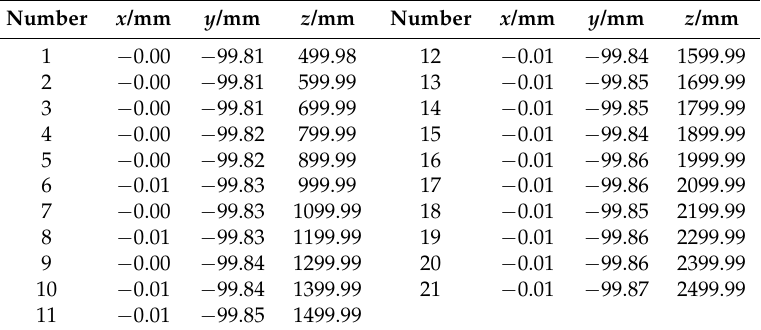
Figure 5. The images of P in the left and right simulated cameras. ( a ) left image; ( b ) right image. Table 3. The ground truth of the 3D coordinates of the 21 static target